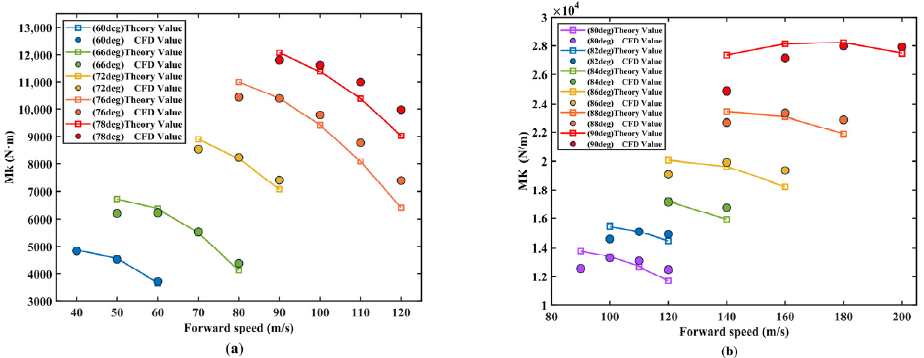
Figure 24. Forwarding Mk calculation at 5 km in 56 rad/s. ( a ) 60°~78° database. ( b ) 80°~90° data ‐ base.